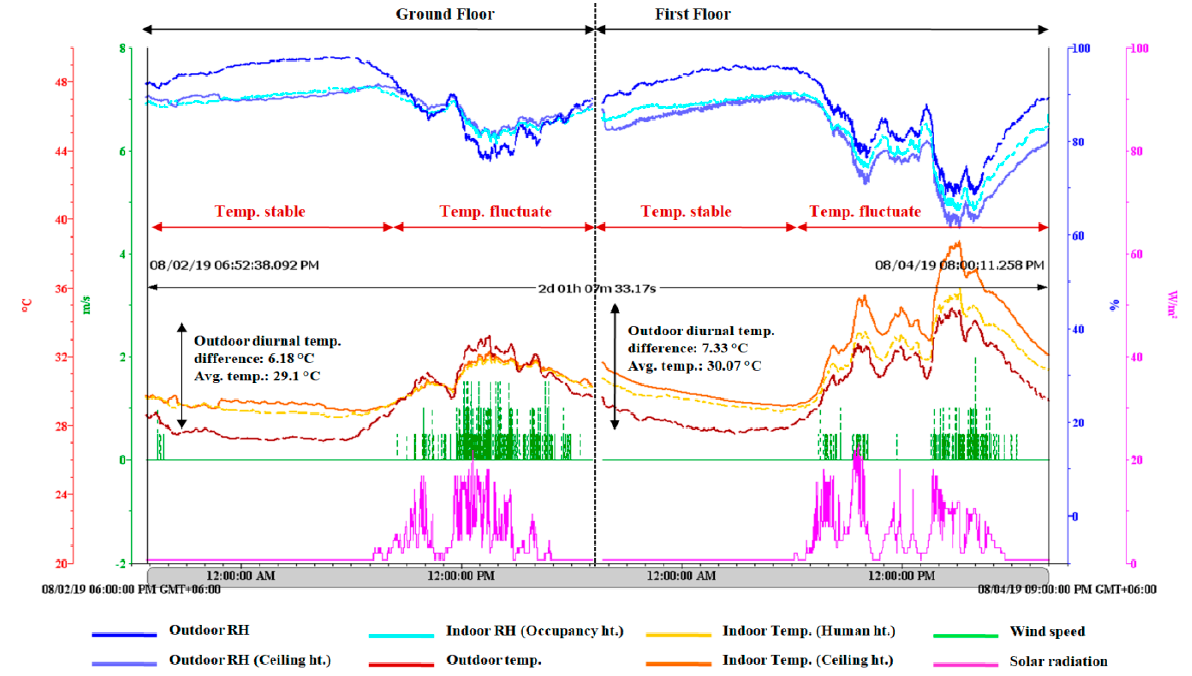
Figure 9. Indoor thermal performance of H-2 (Source: Field data from HOBO weather station). Indoor thermal environmental data (22–24 August 2019) of H-3 for 46 h is presented in Figure 10. The first 24 h cycle shows that outdoor AT fluctuated considerably between 8:00 am–6:00 pm and remained stable at night to early morning. Indoor AT showed a similar scenario. During day, indoor human occupancy level had similar AT that of the outdoor. Ceiling level and outdoor AT had a difference of max. 8.09 ◦ C. In H-3, roof was provided with 19 mm thick wooden shingles just beneath a roof covering resulting in more radiant heat entering indoors compared to H-1 and H-2. Higher room height (average 3.5 m) having no opening at roof level causes warm air to gather at that level.